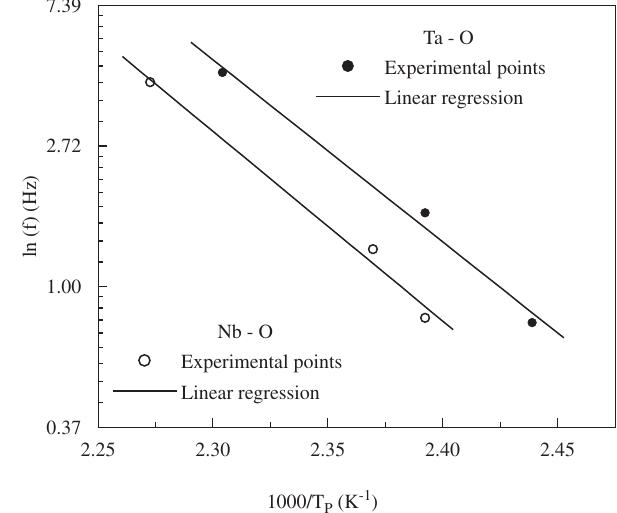
Figure 5. Frequency as a function of the inverse of the peak temperature for Nb-O and Ta-O relaxation